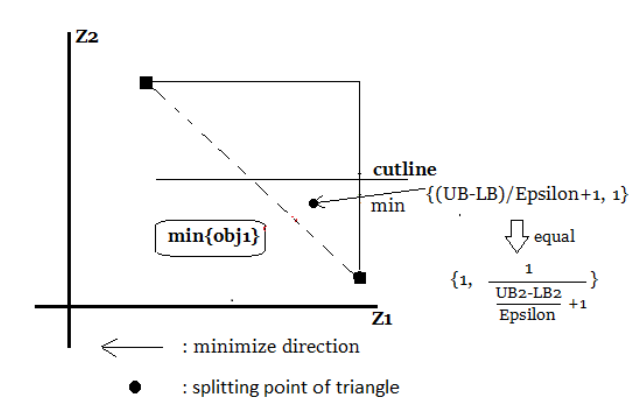
Fig. 2. Geometrical analysis of the equation (3) of the proposed improved